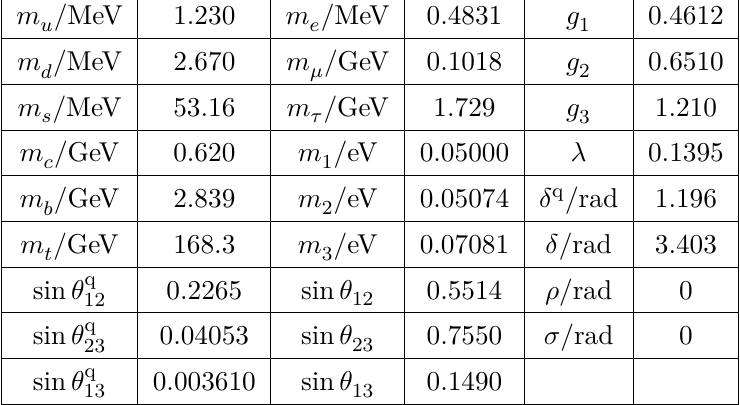
Table 3 . The input values of the relevant SM physical parameters at the initial energy scale = M = 91 . 19 GeV . The flavor mixing parameters { θ q µ 0 Z sector [2], while { θ , θ , θ , δ, ρ, σ } to those in the leptonic sector [30]. The initial values of the 12 13 23 running quark and charged-lepton masses, the gauge couplings g Higgs coupling λ come from ref. [31]. For neutrino masses, we assume the normal mass ordering and take m = 0 . 05 eV . Furthermore, the Majorana CP phases ρ and σ are set to be 1